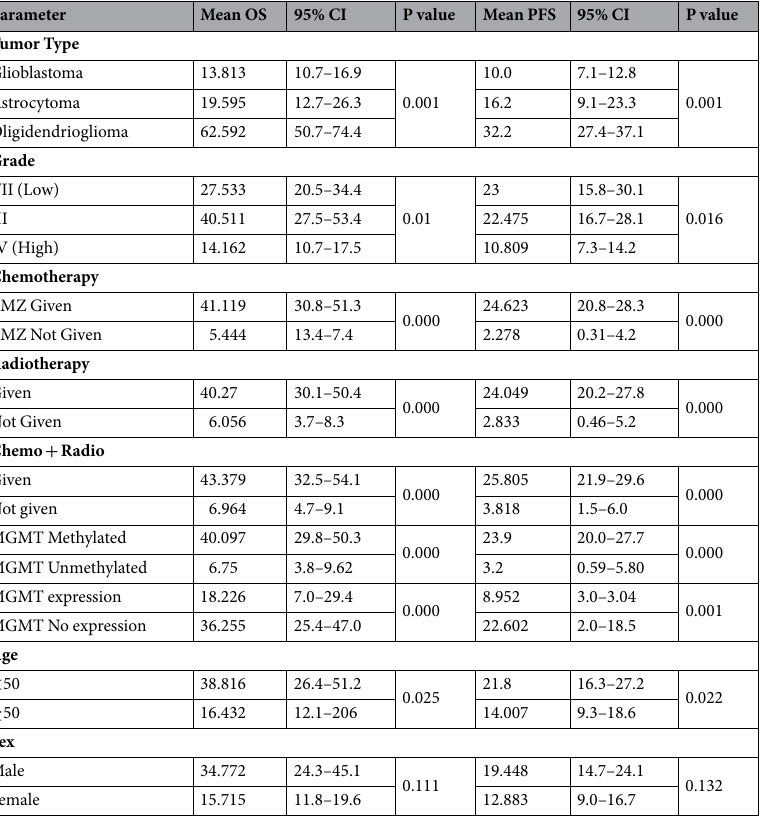
Table 2. Relation of various variables of Glioma patients with respect to survival and progression free survival. TMZ: